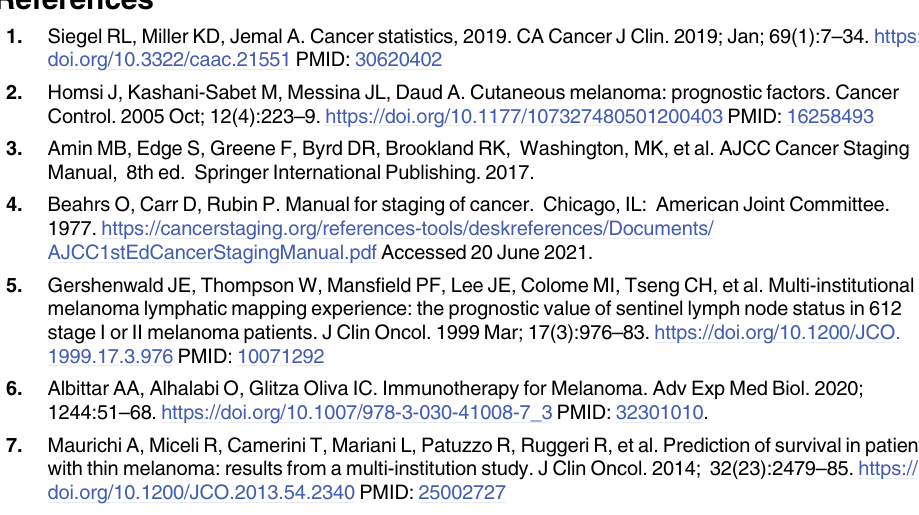
S2 Table. EACCD and AJCC grouping of melanoma of the skin patients according to T, N, and M. S3 Table. EACCD grouping of melanoma of the skin patients according to T, N, M, A,